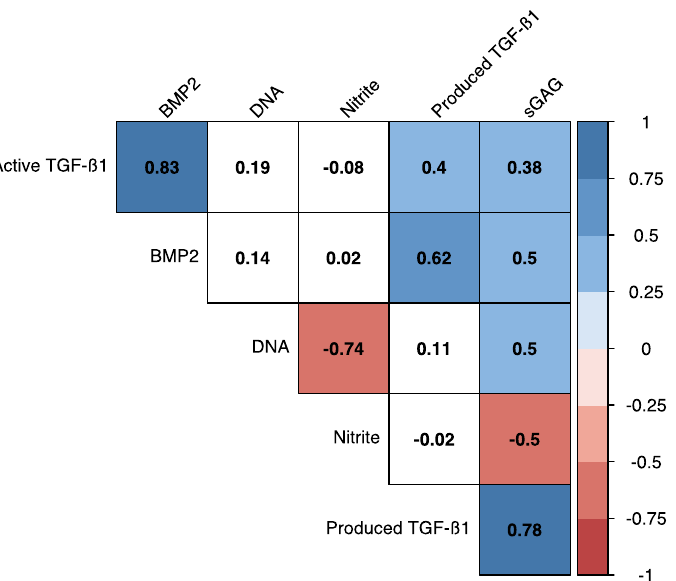
Figure 5. Correlogram of the different response variables. Data from three independent experiments with cells from three individual donors. Each experimental group was run in technical replicates. All response variables are normalized to the DNA content (except the DNA content). Number in squares refers to the Pearson’s r correlation coefficient. p < 0.05 for all squares that are not blank. Red colors refer to negative correlation, blue colors refer to positive correlation. Supp. Fig. 6 shows the correlograms according to the different loading